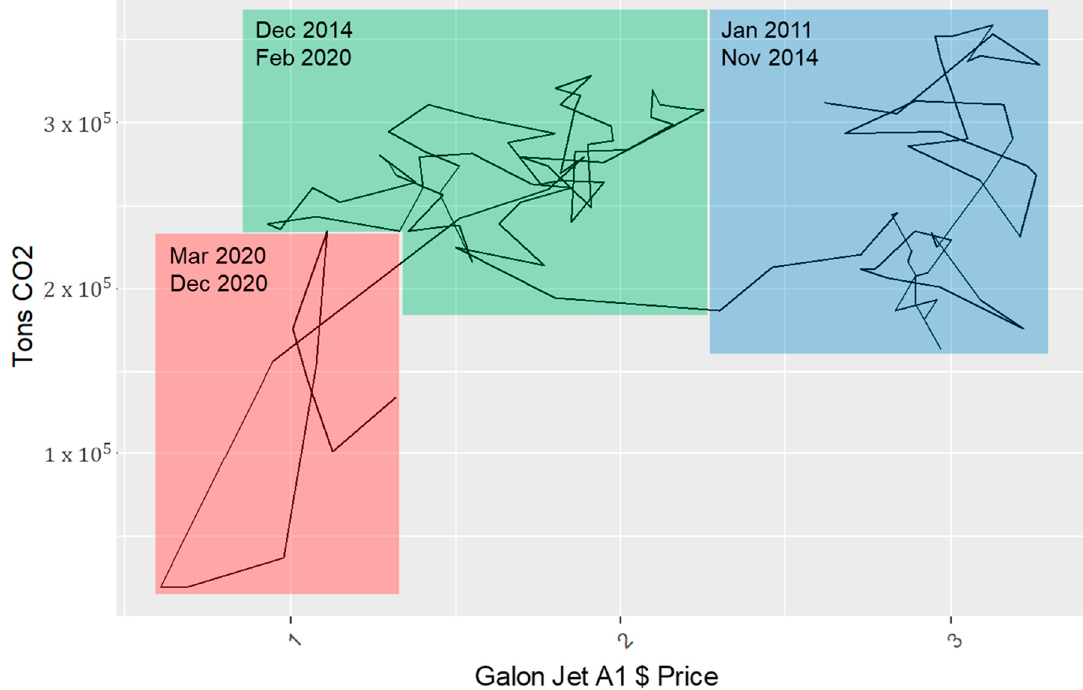
Figure 15. Trend analysis of carbon dioxide emissions and fuel prices. Source: own elaboration based on data compiled from [19] and weighted from [20] according to [28,29].